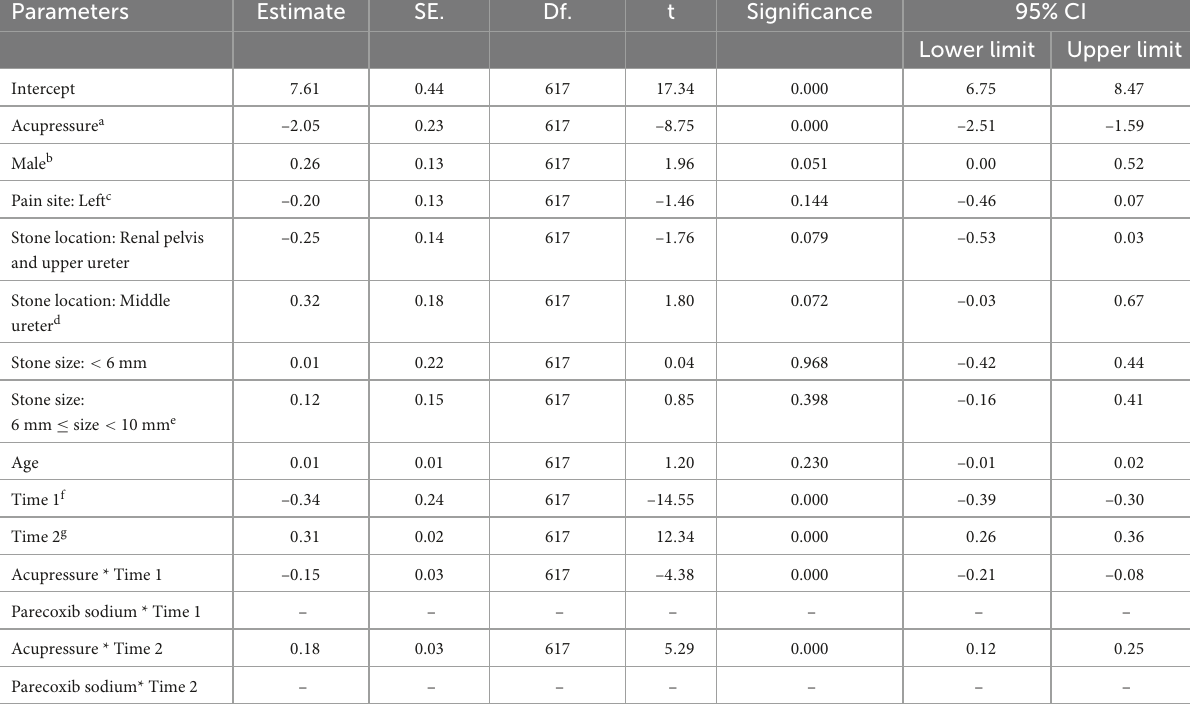
TABLE 5 The estimation of visual analog scale (VAS) decreasing rate in linear mixed effects models.